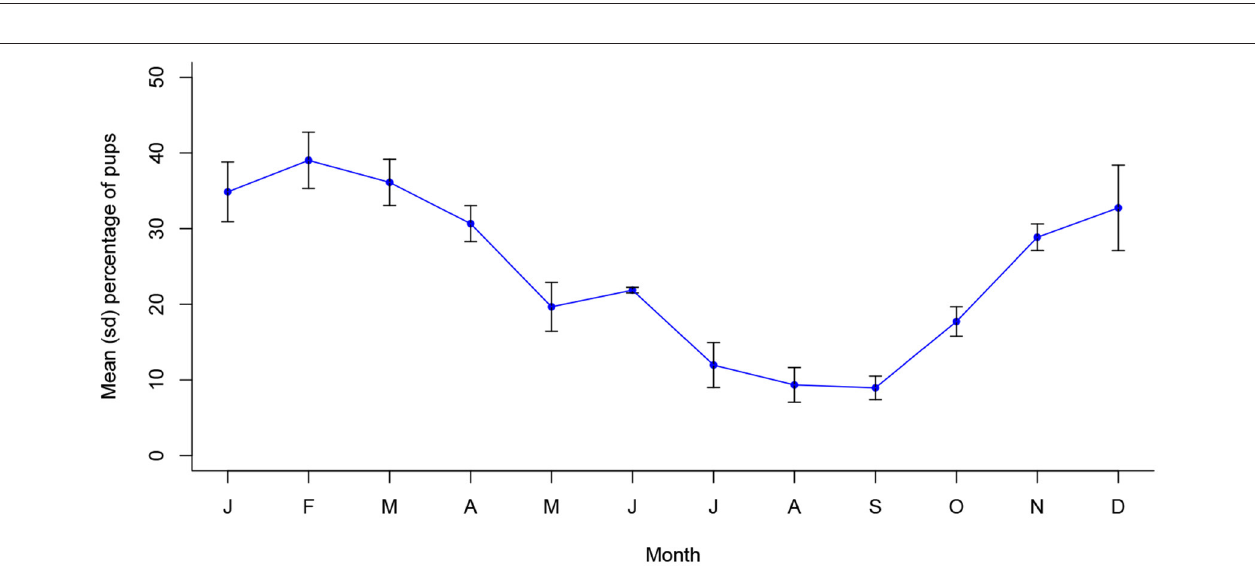
FIGURE 3 | Mean (sd) monthly proportion of pups in Jamshedpur, India between 2013 and 2016 ( n = 15,610).